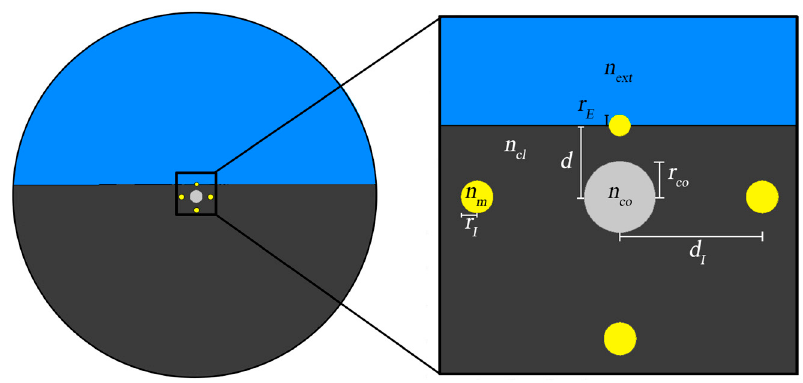
Figure 10. Configuration of the proposed SPR D-type fiber with one external and three internal metallic nanowires for simultaneous measurement.